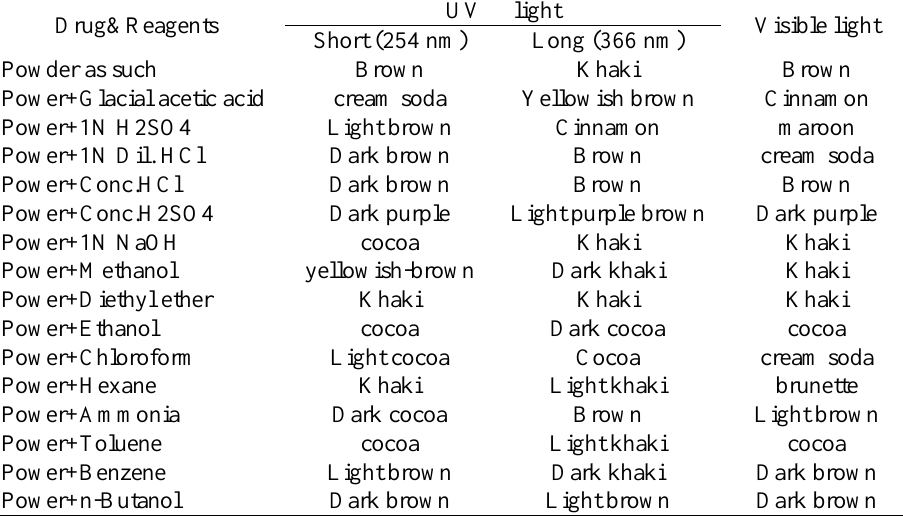
Table 4. Fluorescence analysis of the successive extracts of P. sinjiangensis K. Y.